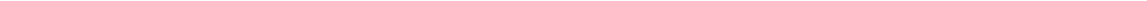
comparison test, n = 6 per group. g Fibrotic proteins were examined by western blotting. Quantitative measurements of Fibronectin (FN), Collagen 1A and α -SMA protein expression in kidneys of Wt and mPGC-1 α mice with or without FAN. ** P < 0.01 for Wt-FAN vs. Wt-Sham and # P < 0.05 for mPGC-1 α -FAN vs. Wt-FAN, one-way ANOVA with Bonferroni ’ s multiple comparison test, n = 6 per group. h Kidney function was assessed using serum creatinine concentration in each group. ** P < 0.01 Wt-FAN vs. Wt-Sham, * P < 0.05 for mPGC-1 α -FAN vs. mPGC-1 α -Sham, and # P < 0.05 for mPGC-1 α -FAN vs. Wt- FAN, n = 7 per group, one-way ANOVA with Bonferroni ’ s multiple comparison